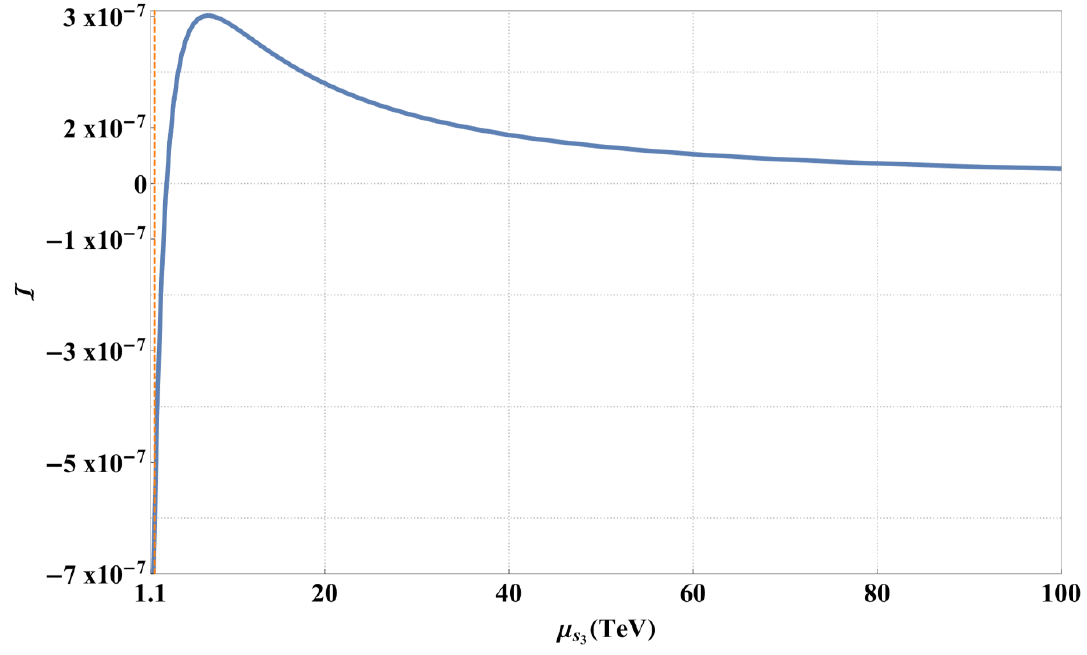
Figure 4 . Plot showing the behaviour of the integral, I , (see equation (2.18)), for leptoquark mass parameter (cid:22) S ranging from 1 : 1 (cid:0) 100 TeV. This corresponds to a physical mass range of 3 m r = m r = 1 : 3 (cid:0) 118 : 9 TeV, while m r = m r remains constant for this range. The other 1 3 2 4